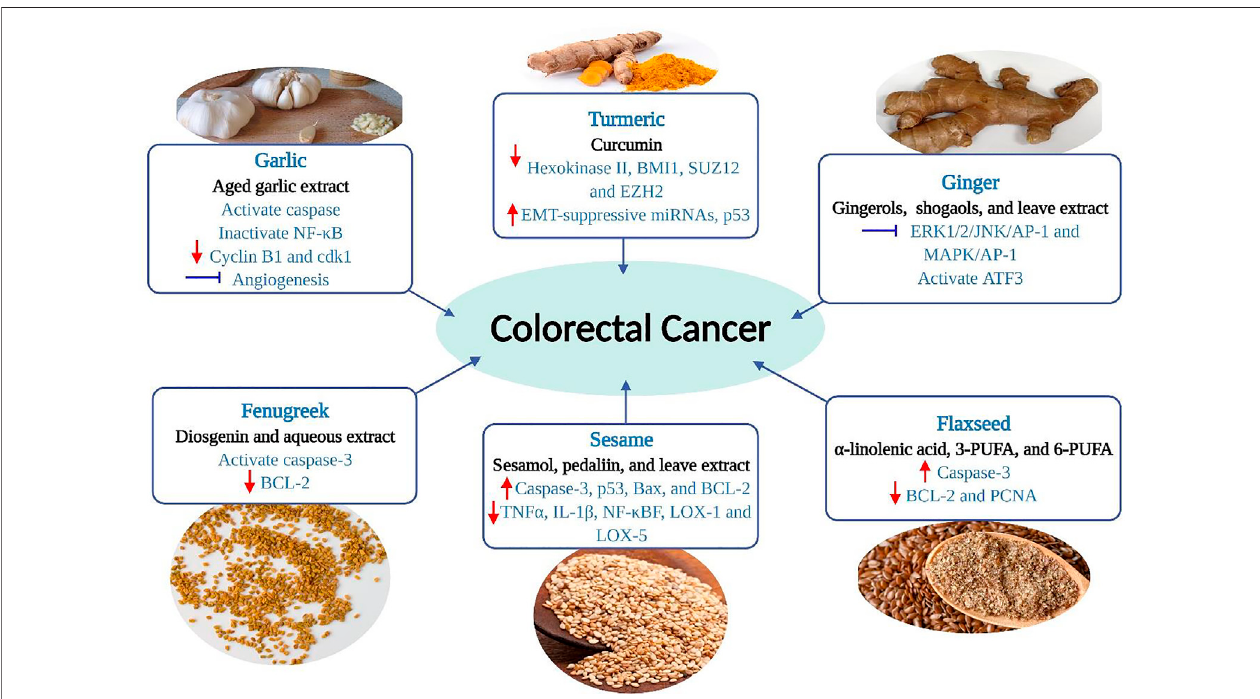
FIGURE4| Chemopreventiveeffectsofselectedherbsandspicesagainstcolorectalcancerbytargetingdiversemechanismsofaction.Theredarrow(up)denotes stimulation or up-regulation, the red arrow (down) denotes down-regulation, and a bar perpendicular to the end of the line (blue) denotes inhibition. AP-1, activator protein 1; ATF3, activating transcription factor 3; Bax, Bcl-2 associated X protein; BCL-2, B-cell lymphoma-2; cdk1, cyclin-dependent kinase 1; BMI1, B cell-speci fi c Moloney murine leukemia virus integration site 1; COX-2, cyclooxygenase 2; EMT, epithelial-to-mesenchymal transition; Erk, extracellular signal-regulated kinase; EZH2, enhancer of zeste homolog 2; JNK, c-Jun N-terminal kinase; LOX, lipoxygenase; MAPK, mitogen-activated protein kinase; NF- κ B, nuclear factor-kappa B; p53, tumor protein p53; PCNA, proliferating cell nuclear antigen; PUFA, polyunsaturated fatty acids; SUZ12, suppressor of zeste 12; TNF, tumor necrosis